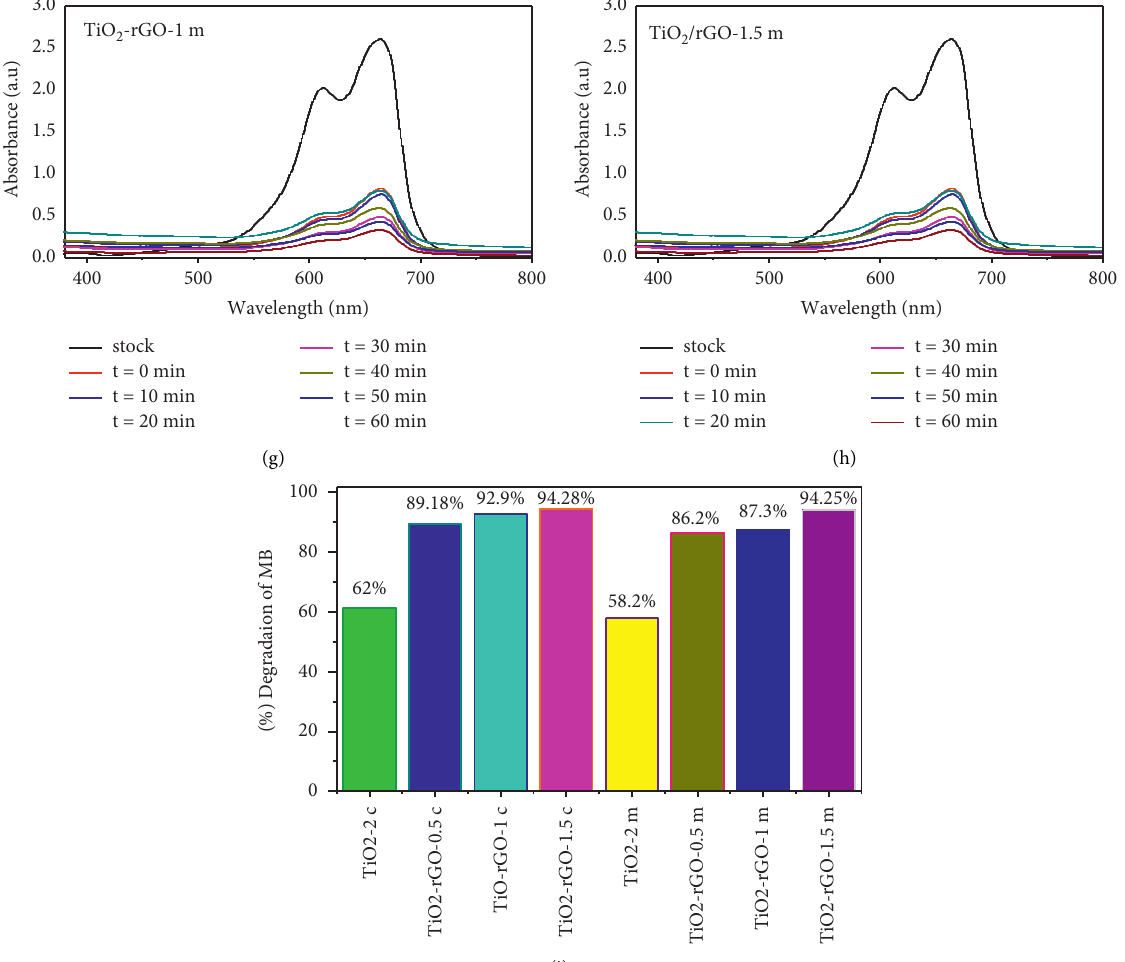
2 NPs and TiO 2 /rGO